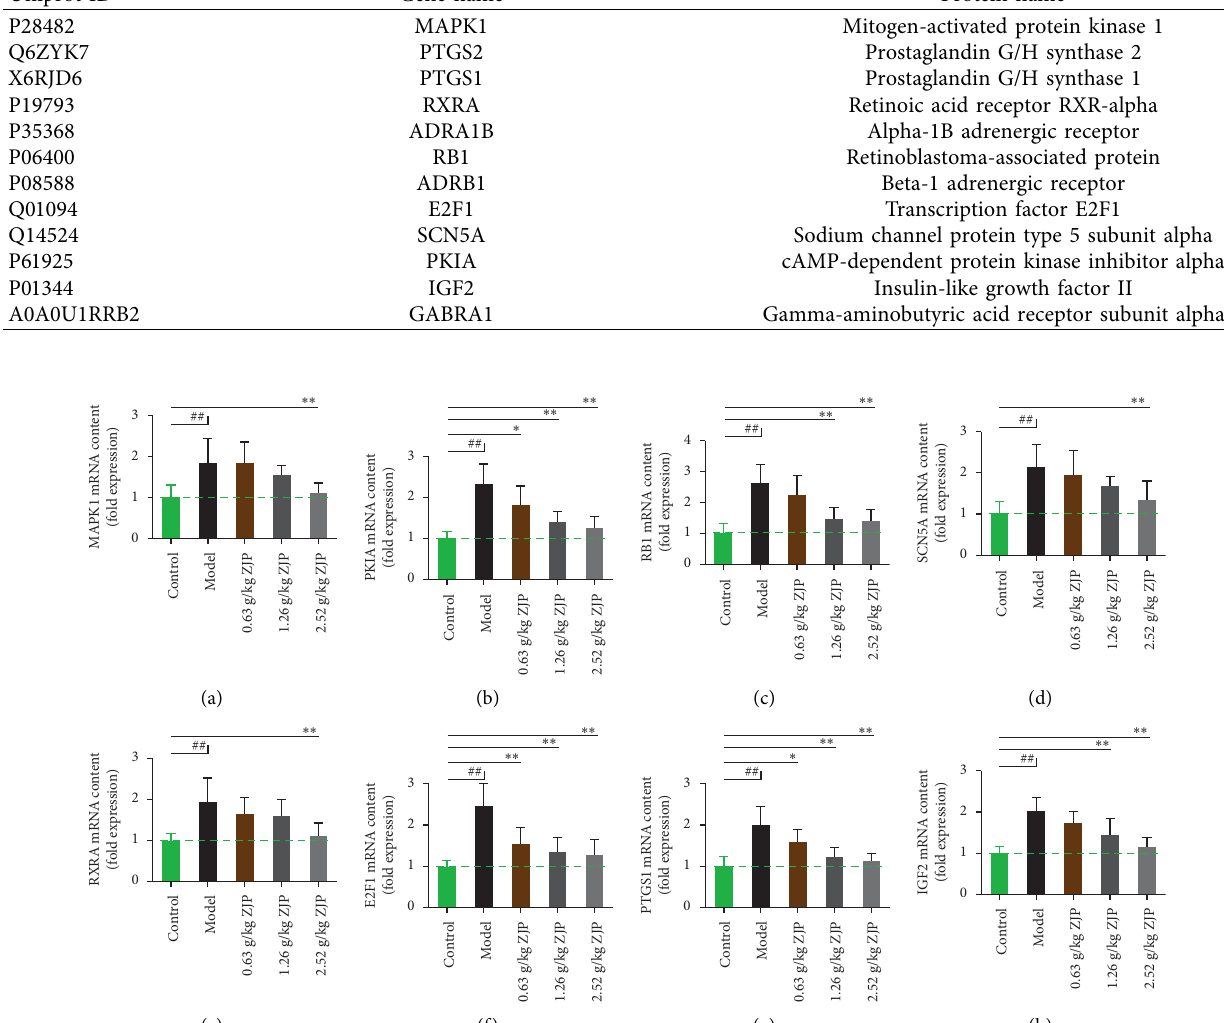
Table 4: Participating in the “Component-Target-Potential Metabolite” interactive network for ZJP treatment of CAG. Uniprot ID